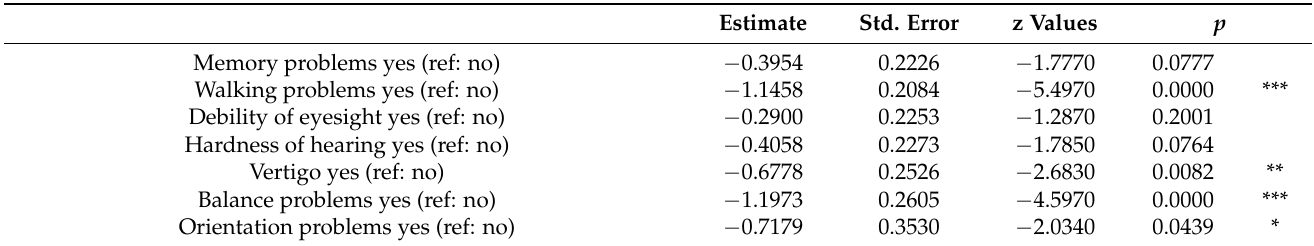
Table 4. General linear model of self-perception compared to others regressing on several conditions in separate models controlling for sex, age, and education (data not shown); * p < 0.05, ** p < 0.01, *** p < 0.001. Estimate